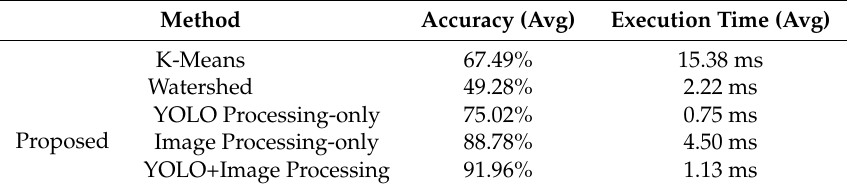
Table 2. Comparison of accuracy and execution